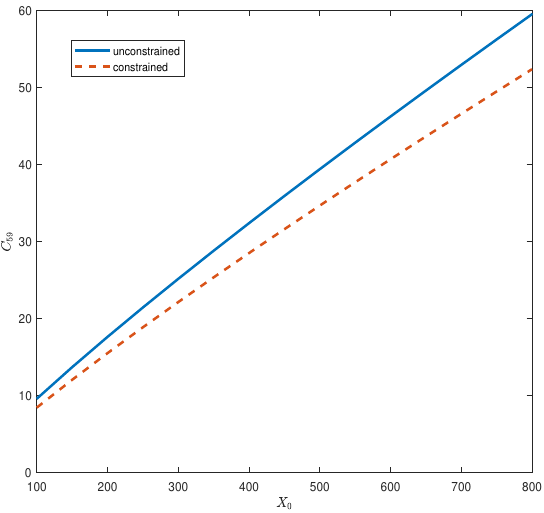
Figure 8. Optimal consumption C at time 59 as a function of initial wealth X 0 .